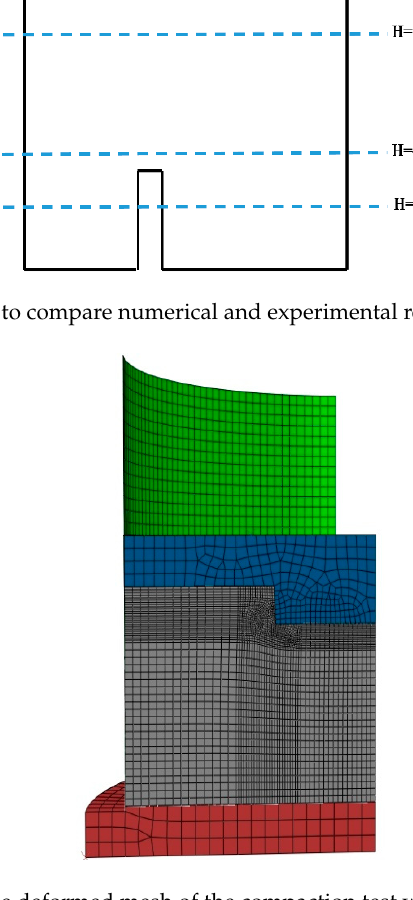
Figure 30. Density profile along the radius (slot): experiment vs. finite element result (h = 30 mm). Figure 23. The deformed mesh of the compaction test with the stub hole. Figure 23. The deformed mesh of the compaction test with the stub hole. Figure 25. The deformed mesh of the compaction test with the stub hole.